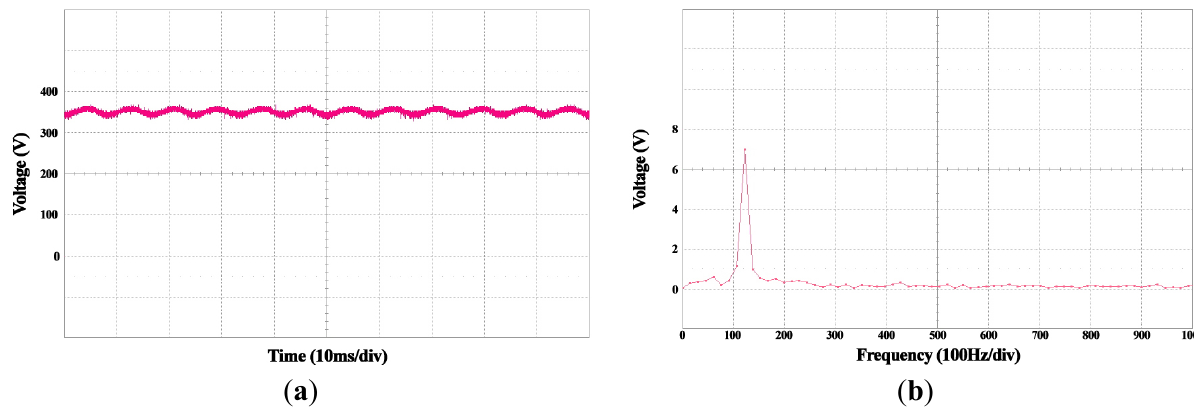
Figure 21. Magnitude of DC-link voltage. ( a ) Time domain; ( b ) frequency